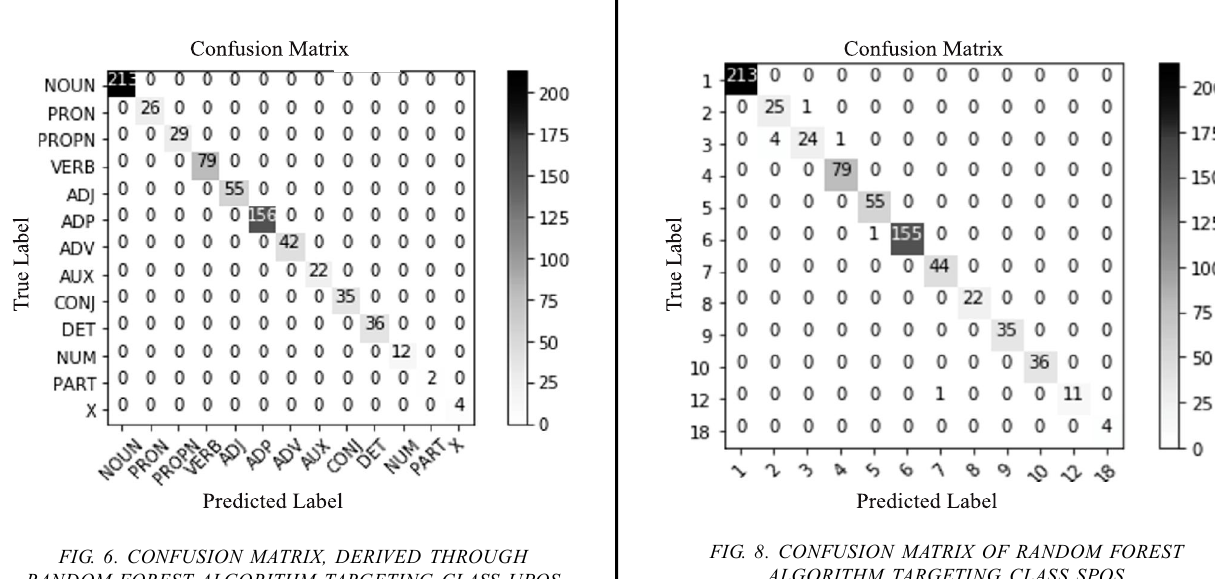
FIG. 7. CONFUSION MATRIX OF SVM NON-LINEAR ALGORITHM TARGETING CLASS SPOS